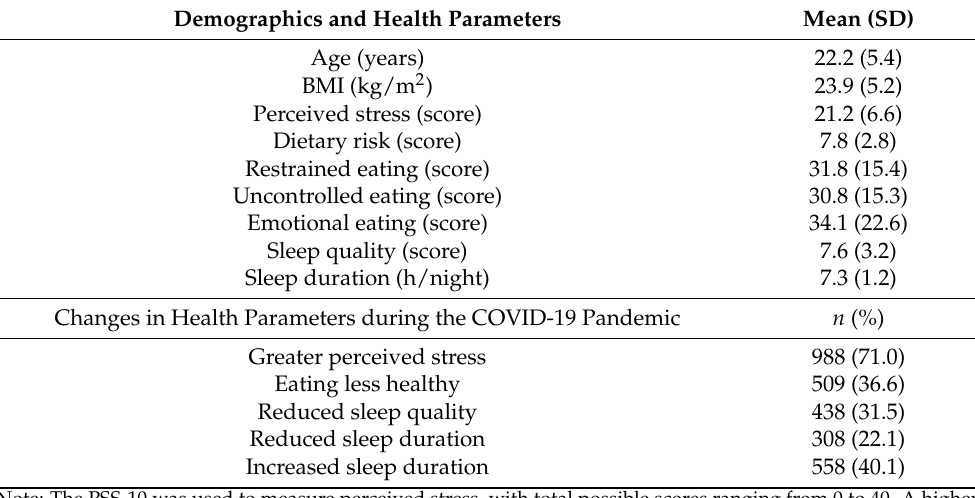
Table 2. Demographics, health parameters, and changes in health parameters during the COVID-19